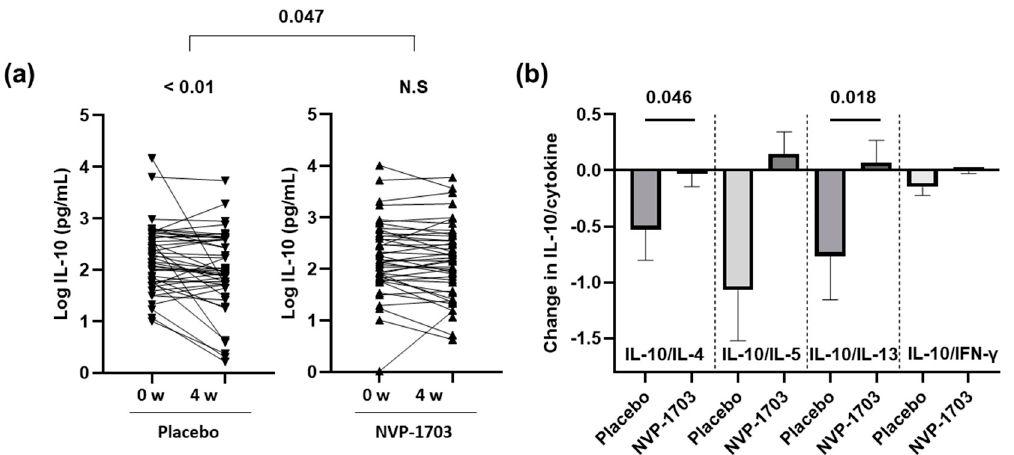
Figure 3. E ff ects of NVP-1703 on blood levels of IL-10 expression as well as ratios of IL-10 to IL4, IL-5, IL-13, and IFN- γ . ( a ) IL-10 expression at each time point (baseline, 4 weeks) after log transformation; ( b ) change in the ratios of IL-10 to IL-4, IL-5, IL-13, and IFN- γ from baseline at week 4. The ratio of IL-10 to IL-5 increased by 0.15 ± 0.20 in the NVP-1703 group ( p > 0.05), while Table 4. Changes in immunological parameters.